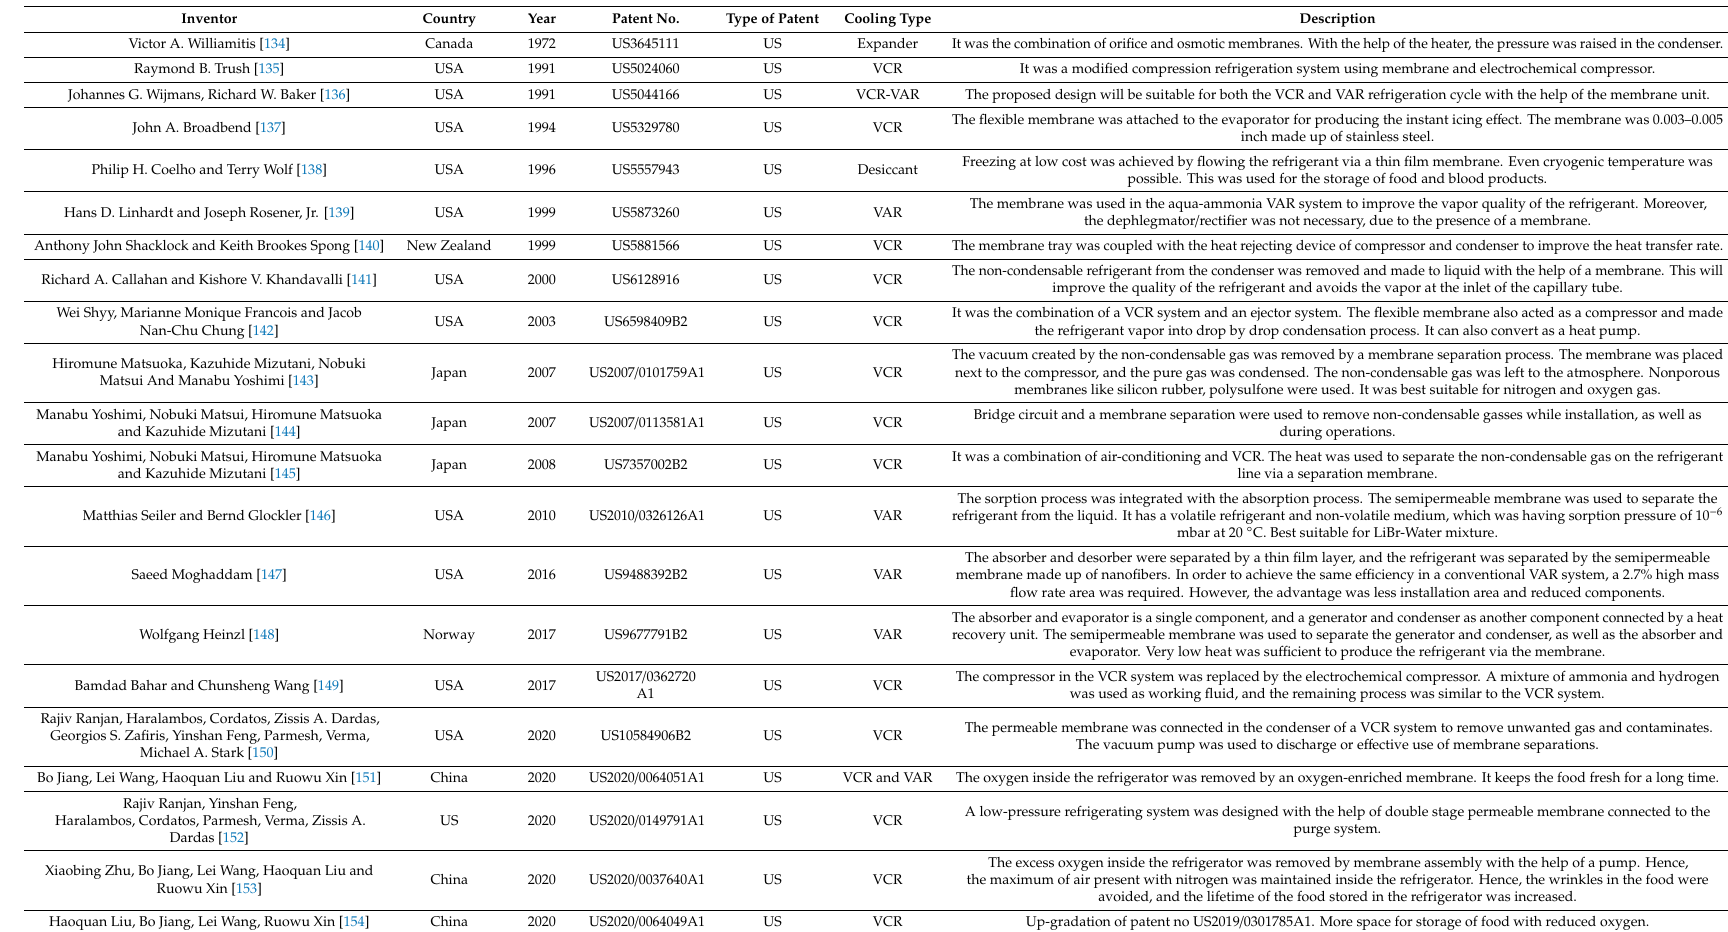
Table 3. Patents in membrane related absorption